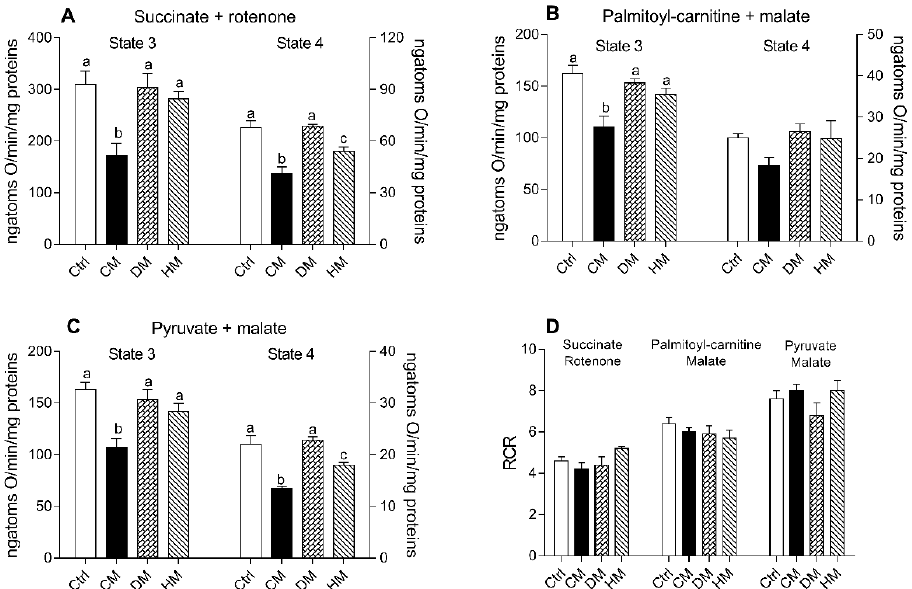
Figure 3. Cow milk (CM), donkey milk (DM) or human milk (HM) diet supplementation modulates the rat cardiac mitochondrial oxidative capacity. The mitochondrial respiration rates were evaluated in the presence of succinate-rotenone ( A ) or palmitoyl-carnitine-malate ( B ) or pyruvate-malate ( C ) as substrates, in the presence (state 3) or absence (state 4) of ADP. Relative respiratory control ratios (RCR) were reported ( D ). Data were expressed as the means ± SEM n = 7 animals/group. Different letters (a,b,c) on top of the bars indicate statistically significant differences ( p < 0.05) among